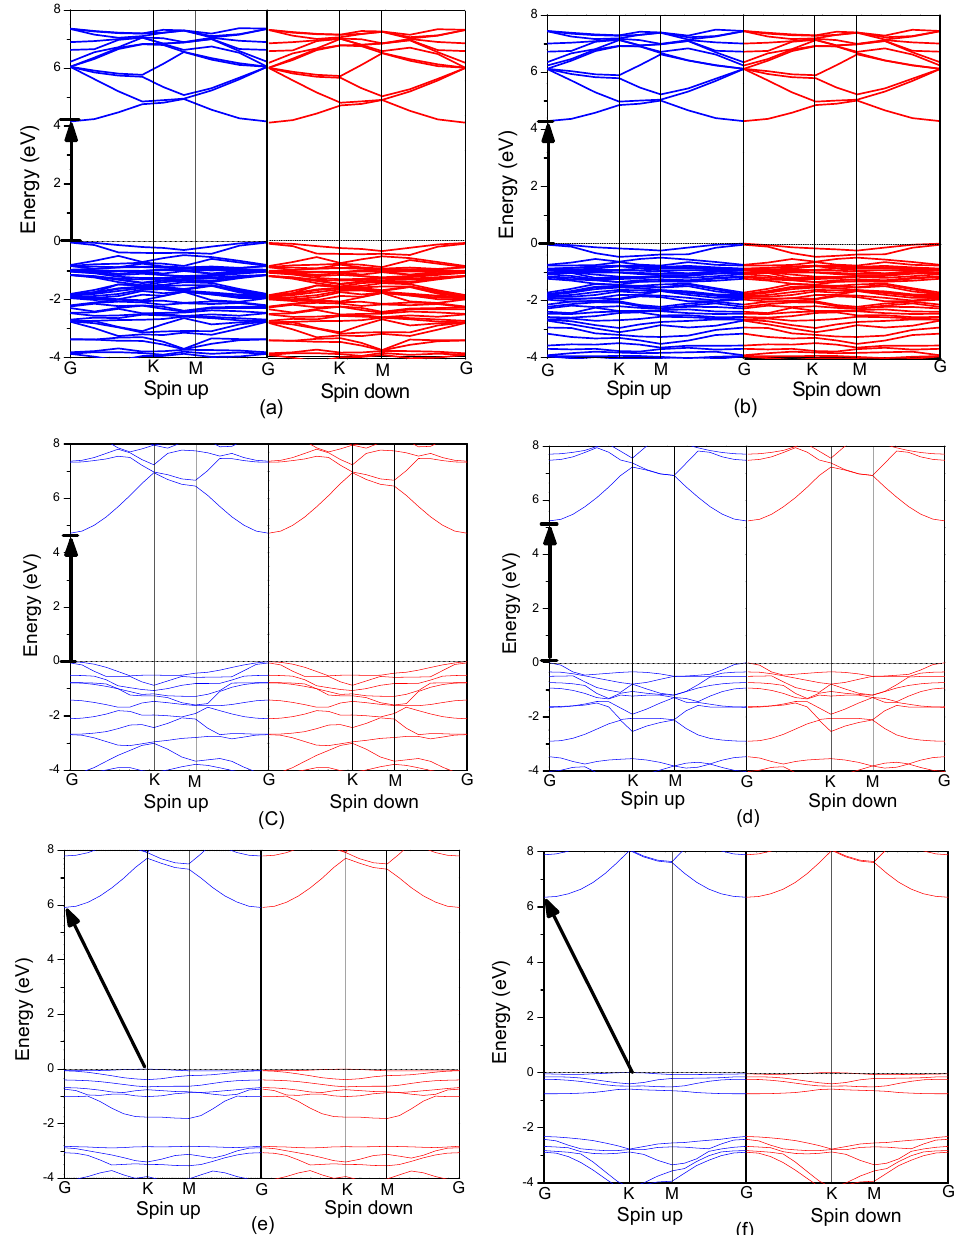
Figure 3. The band structures of Mg x Zn 1 − x O monolayer ( a ) x = 0.0625; ( b ) x = 0.125; ( c ) x = 0.25; ( d ) x = 0.5; ( e ) x = 0.75; ( f ) x = 1.